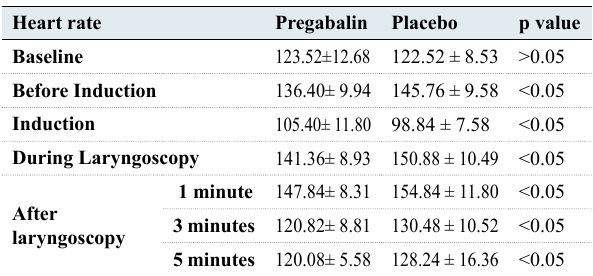
Table 3: Comparison of Systolic Blood Pressure (Mean) in two groups